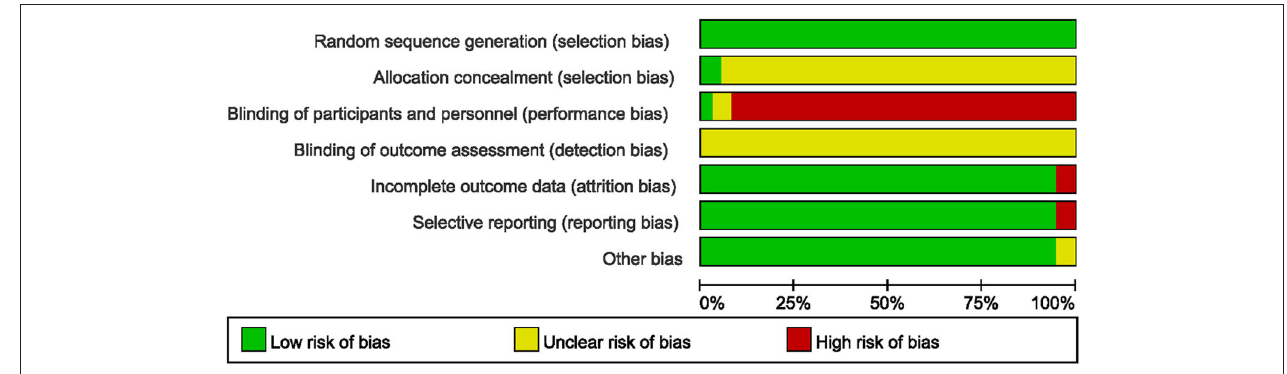
FIGURE 3 | Risk of bias graph for all included